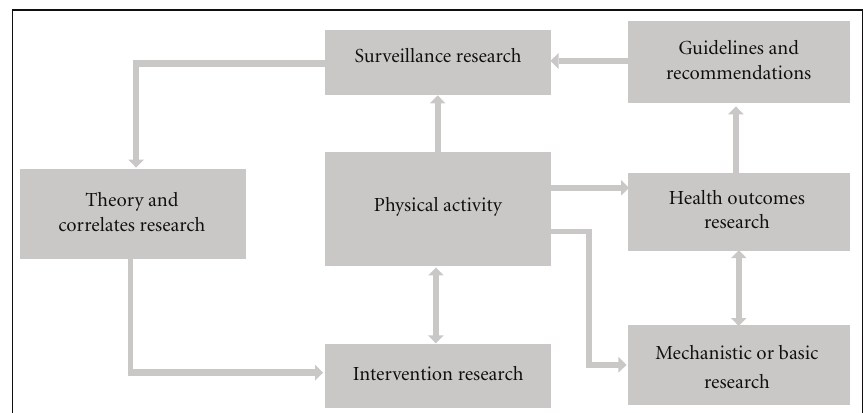
F 2: A model of physical activity epidemiology reproduced from